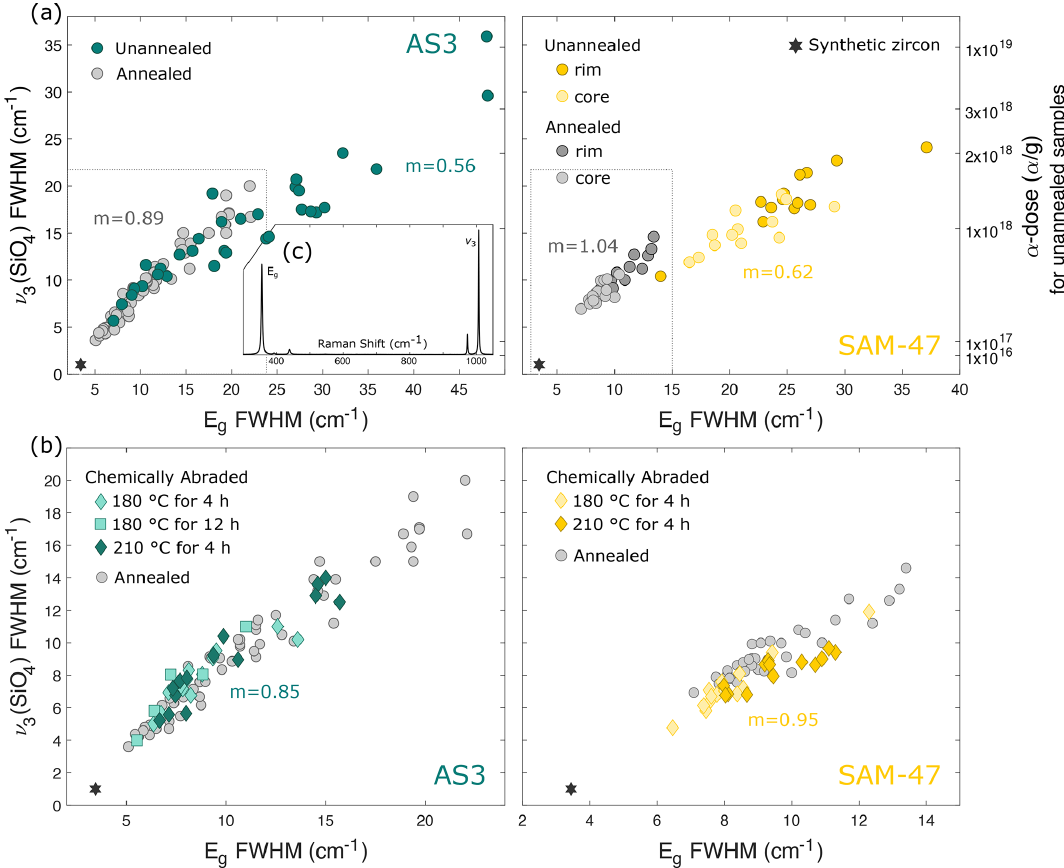
Figure 5. Raman v 3 (SiO 4 ) and E g peak width data for intermediate- to high-damage samples AS3 and SAM-47. (a) Results for unannealed and annealed (900 ◦ C for 48h) zircon samples. Alpha dose estimates for unannealed zircon samples derived from measured v 3 (SiO 4 ) peak widths are shown on the right y axis (Váczi and Nasdala, 2017). Slopes ( m ) for unannealed and annealed samples were calculated assuming a simple linear regression. Gray boxes mark the plot area presented in (b) . (b) Results for chemically abraded residues compared to annealed samples. Reported slopes are inclusive of all leaching conditions. (c) Representative spectrum of synthetic zircon with peak